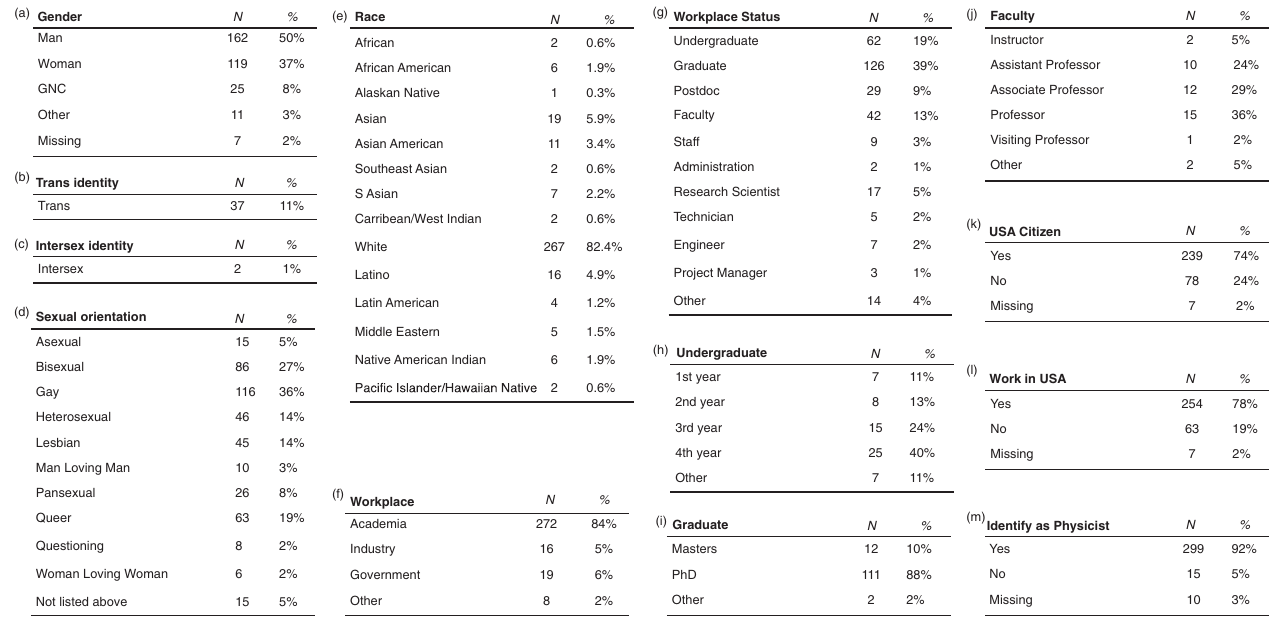
FIG. 1. Demographic information of survey participants.